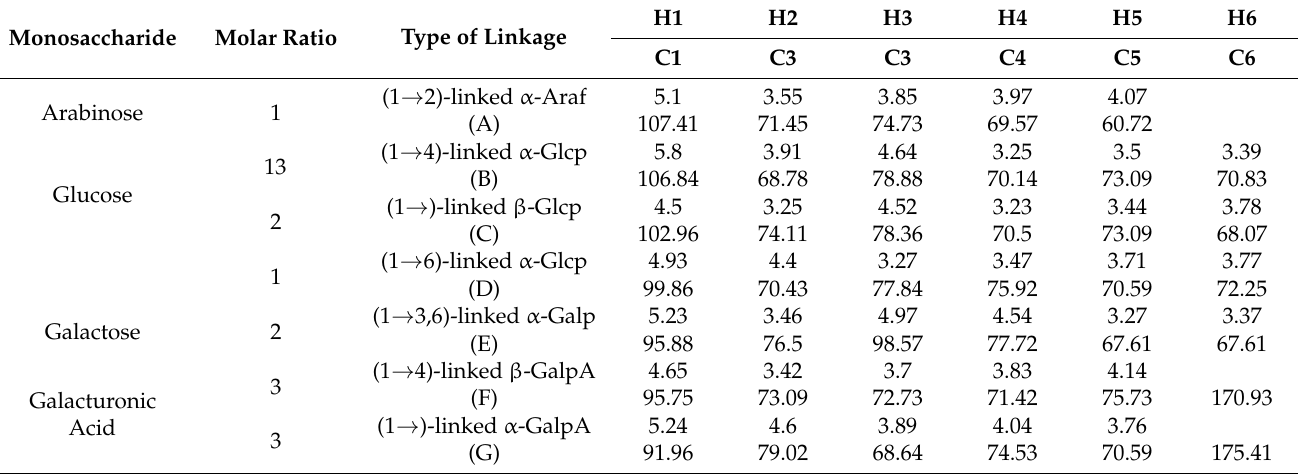
Figure 3. NMR spectra of PPL-1: 1 HNMR ( A ), 13 CNMR ( B ), 1 H– 1 HCOSY ( C ), HSQC ( D ), HMBC ( E ) and DEPT-135 ◦ ( F ). Predicted structure of the repeating units of PPL-1 ( G ). ( F ) In the DEPT-135 ◦ spectrum, the first-order carbon atoms (CH3) and third-order carbon atoms (CH) are the upward peaks, the second-order carbon atoms (CH2) are the downward peaks and there is no peak of fourth-order carbon atoms ( C ). Table 3. 1 HNMR and 13 CNMR Chemical Shifts of PPL-1.